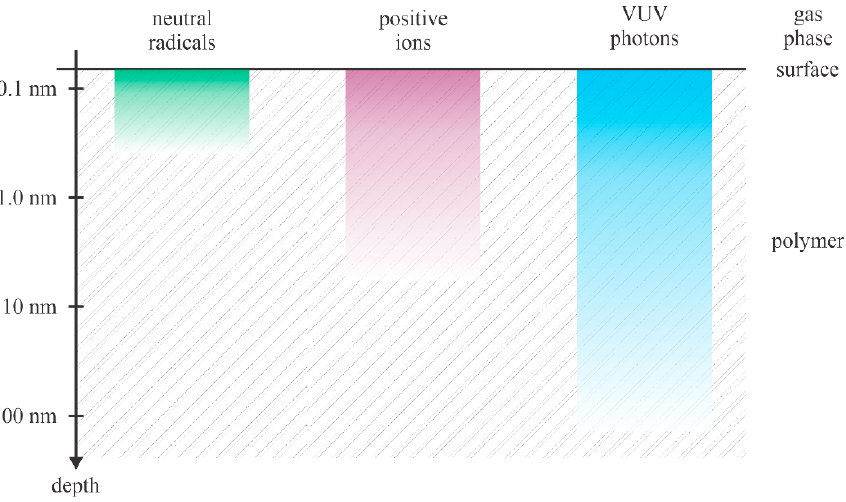
Figure 4. The penetration depth of neutral radicals, positively charged ions, and VUV radiation in PET.